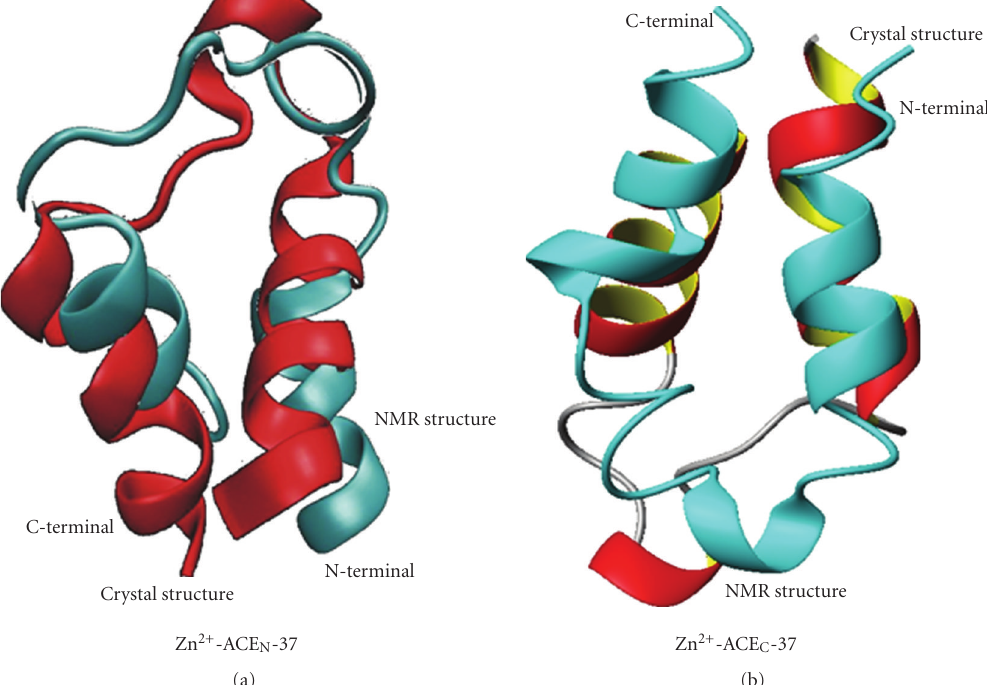
Figure 9: Superimposition of the crystal structure (in red) and the solution structure derived from NMR data (in cyan) of Zn 2+ -ACE N (37) peptide (a) and Zn 2+ -ACE C (37) peptide